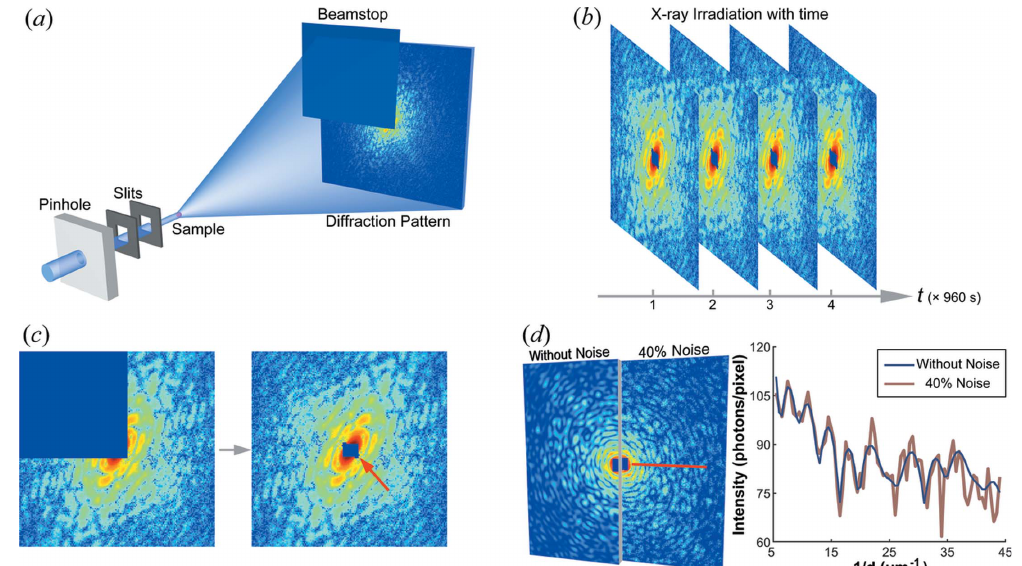
Figure 1 ( a ) A schematic layout of plane-wave CDI. ( b ) The four diffraction patterns from a mitochondrion after different total accumulated exposure times. ( c ) Each experimental diffraction pattern was partially blocked by a beamstop, as shown on the left. The red arrow points to the missing data remaining after enforcing centrosymmetry. ( d ) Simulated diffraction patterns with and without Poisson noise. The line scan (taken along the red line in the pattern) shows the variation in diffraction